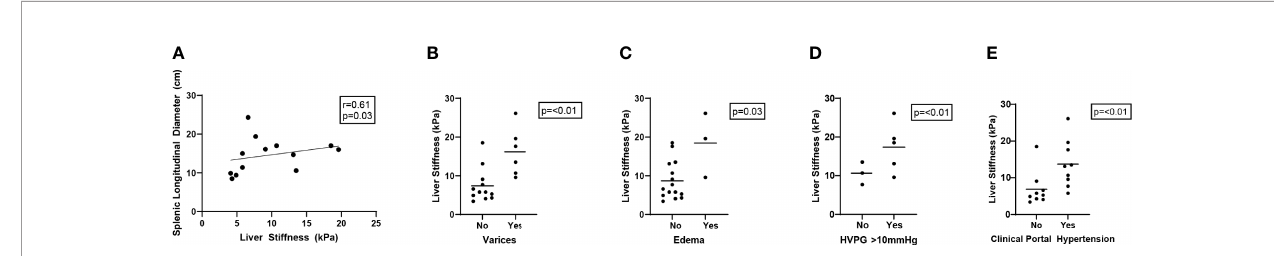
FIGURE 3 | Liver stiffness by transient elastography correlates with clinical parameters of portal hypertension in CVID patients. Liver stiffness measurements (kPa) by transient elastography compared across clinical parameters of portal hypertension in CVID patients, including splenic longitudinal diameter ( A , N = 13 scored), presence of varices (grade 1 – 3) ( B , N = 18 scored), presence of peripheral edema ( C , N = 18 scored), elevated (>10 mmHg) hepatic venous pressure gradient (HVPG) ( D , N = 8 scored), and clinically diagnosed portal hypertension in the electronic medical record based on any combination of these data ( E , N = 18 scored). Signi fi cance by one-way ANOVA with Tukey ’ s post-hoc correction or Spearman ’ s correlation (r) with signi fi cance (p) shown. Line of best fi t (A) and mean value (B – E) are shown. CVID, common variable immunode fi